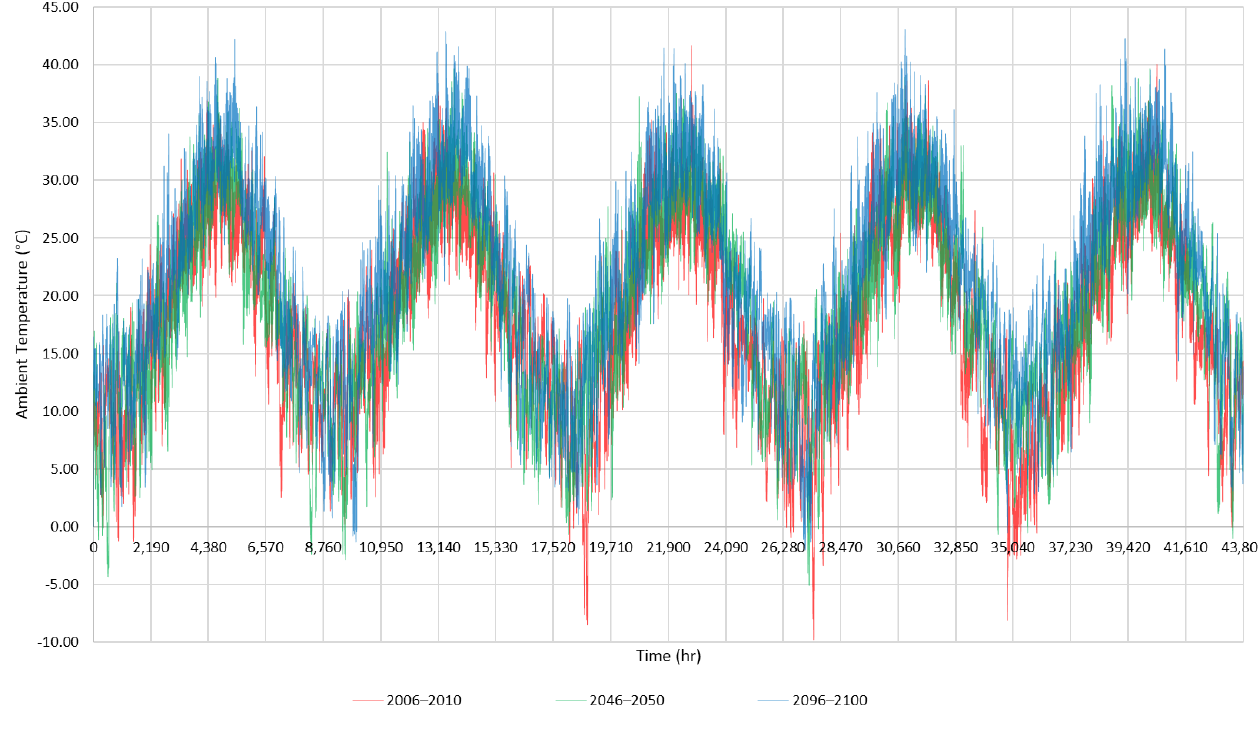
Figure 4. Hourly ambient temperature.